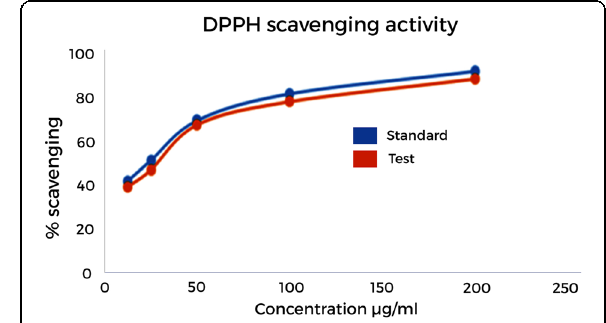
Fig. 8 Effect of compound D1 on brain acetylcholinesterase level